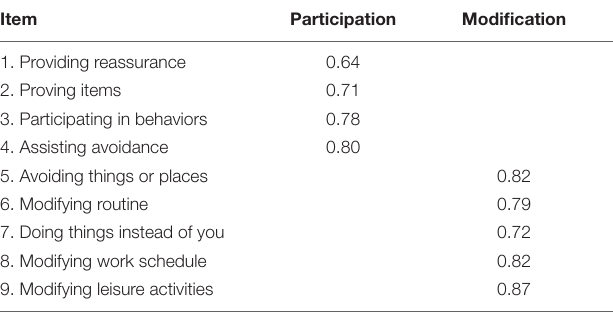
TABLE 1 | Factor loadings of the Family Accommodation Scale Anxiety—Adult